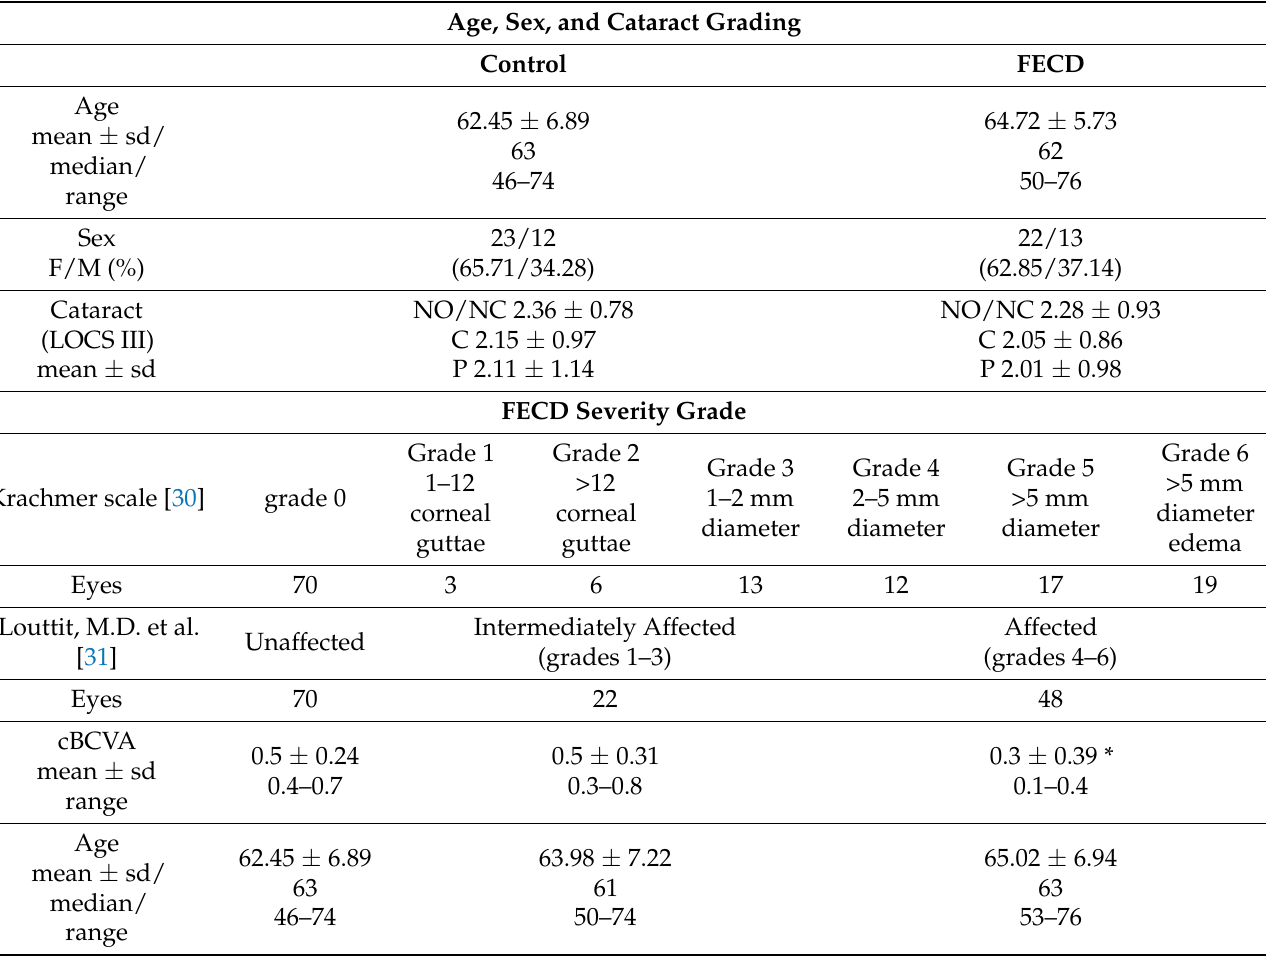
Table 1. Study population characteristics. Significance level of p < 0.05 was marked as “*”. Age, Sex, and Cataract Grading Control